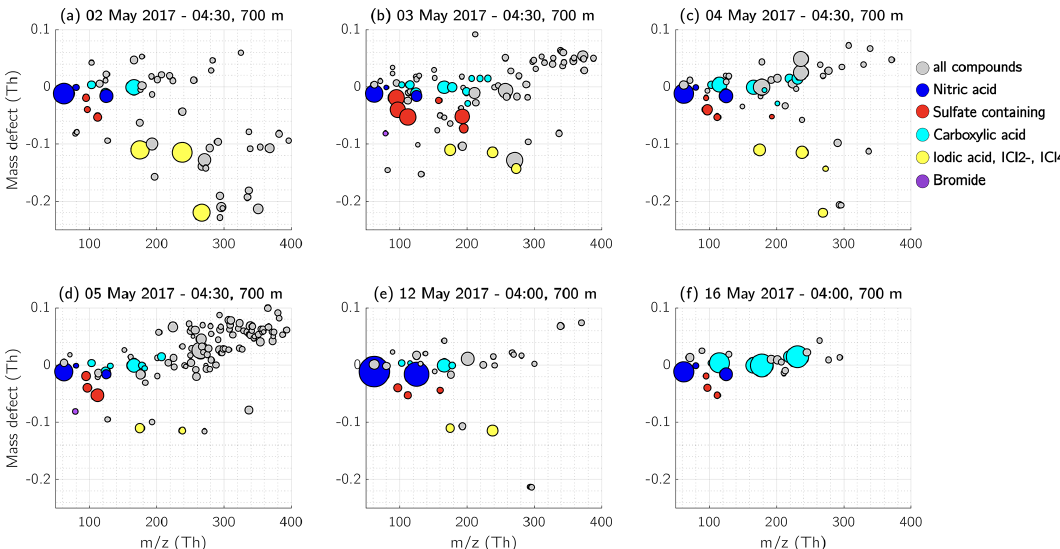
Figure 14. Mass defect of the detected ions in the residual layer at 700m height. Each day of measurement is shown separately. Nitric acid containing ions are coloured dark blue, ions and clusters with sulfuric acid, MSA, or both, and the SO − containing carboxyl functional groups are shown in cyan, and iodic-acid- and iodine-containing compounds in yellow. The size of the dots corresponds to the measured signal (ionss − 1 ).